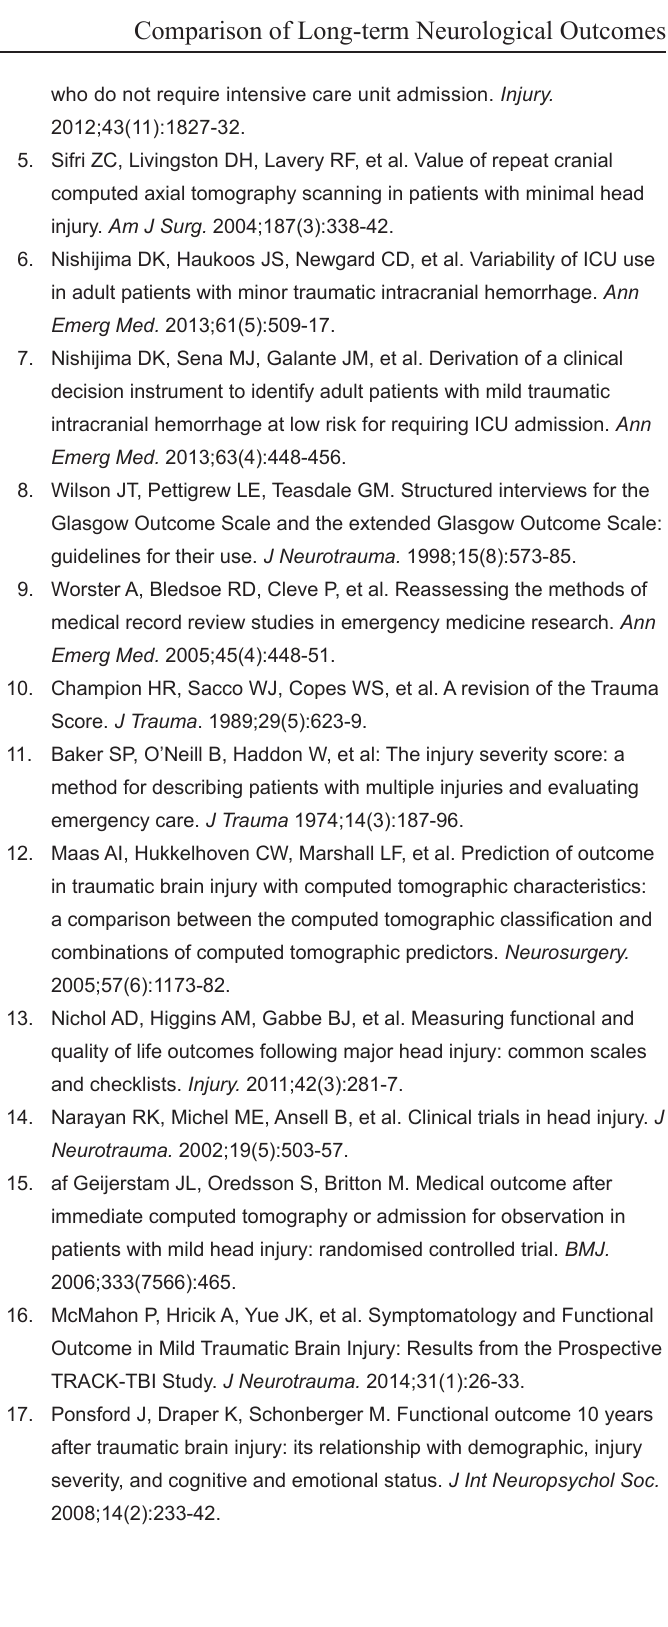
Table 4b. Adjusted analysis for predicting outcome measures.*